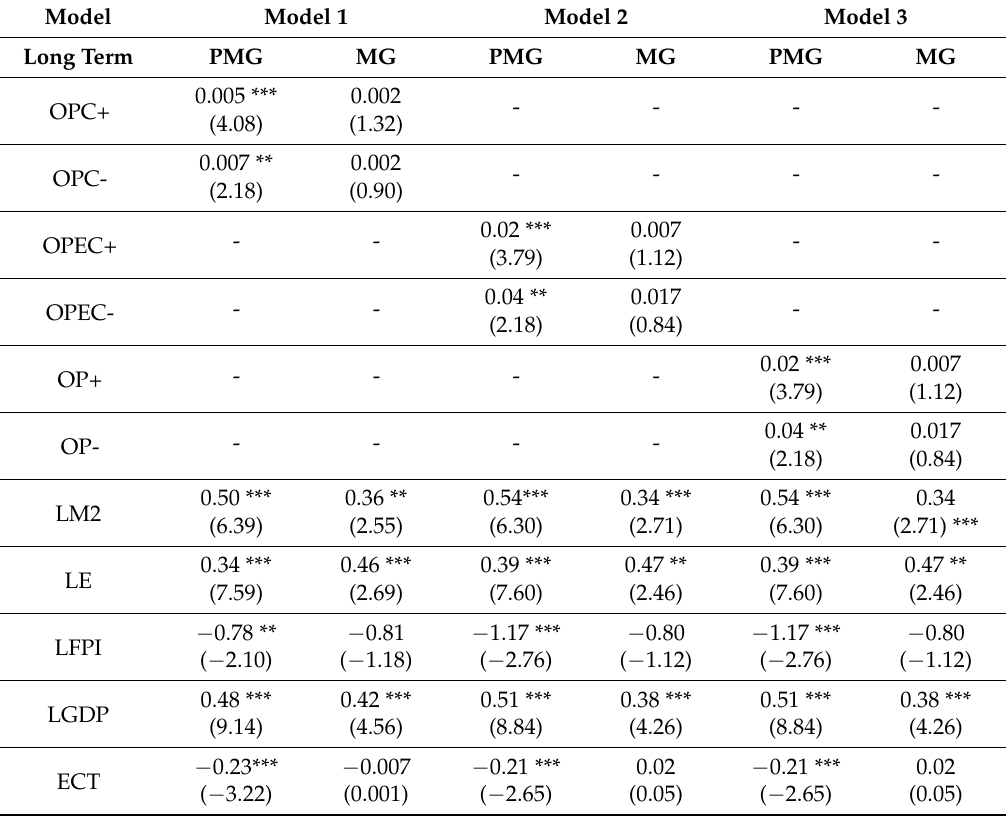
Table 4. Results from the nonlinear pooled mean group (PMG) and mean group (MG) estimators of oil